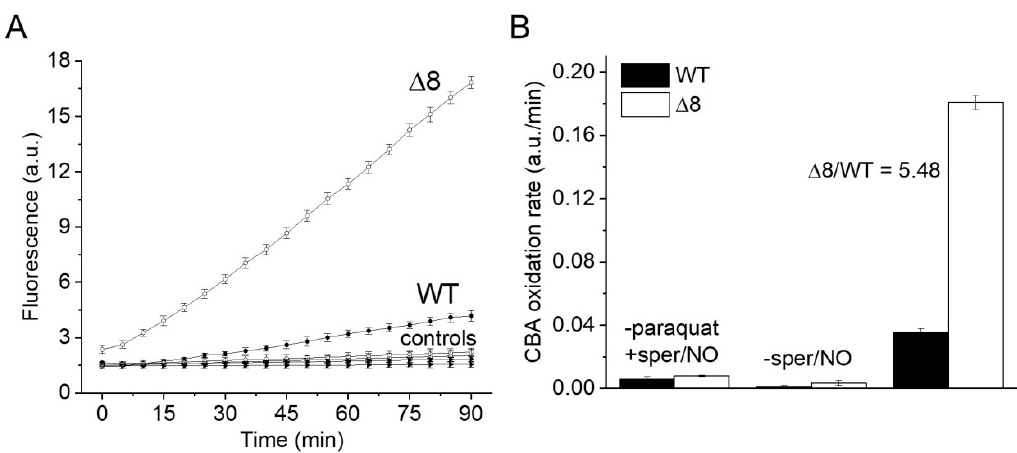
Figure 1. CBA oxidation in suspensions of WT and ∆ 8 Saccharomyces cerevisiae cells by peroxynitrite fluxes. WT and ∆ 8 S. cerevisiae cells were suspended in PBS supplemented with 100 µ M DTPA (diethylenetriaminepentaacetic acid; pH 7,4) and 10 µ M CBA, and placed in 96-well plates. Then, 10 µ M paraquat and 50 µ M sper / NO (PQ / NO • donor) were added to selected wells, and the